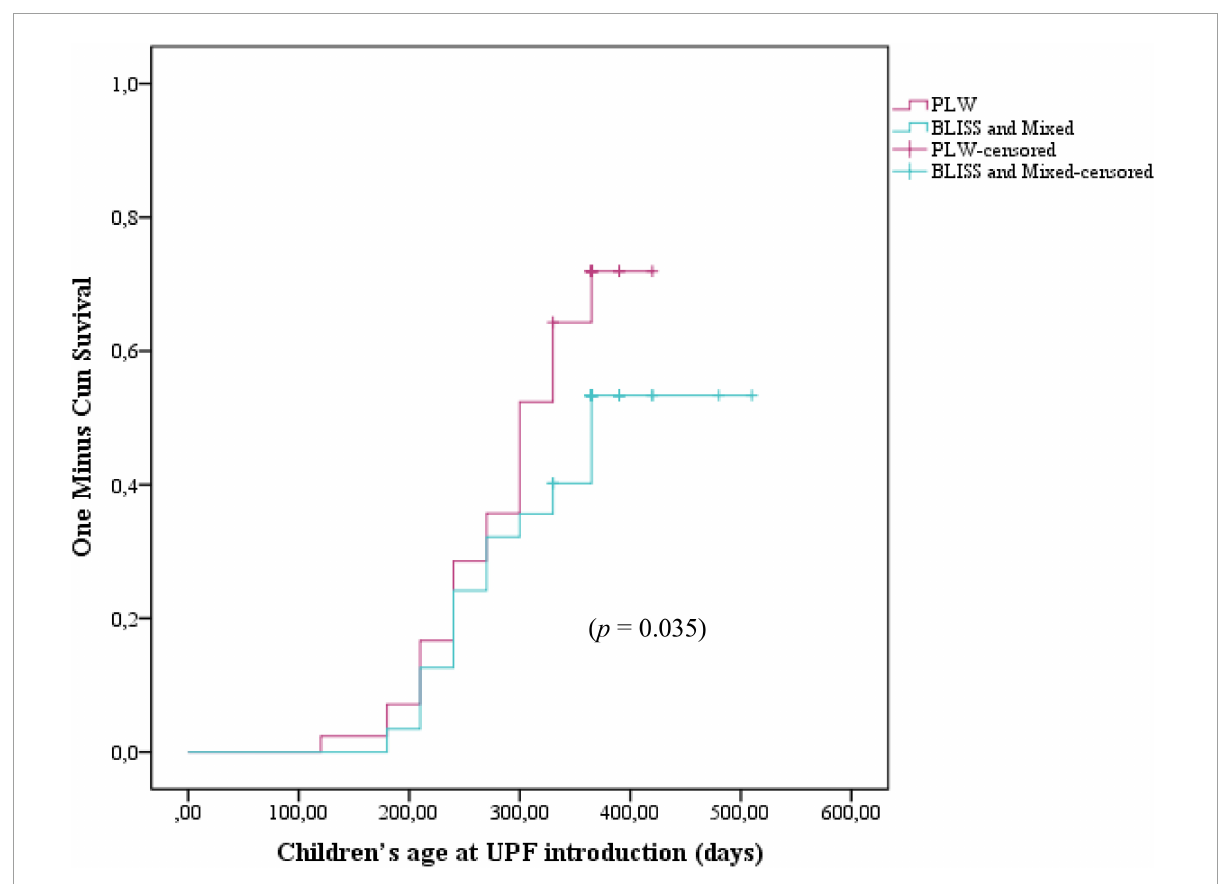
FIGURE4 Kaplan–Meier curve displaying the probability of being introduced to ultra-processed foods in the first year of children’s life according to interventions: PLW, BLISS, and mixed groups, Brazil, 2019–2021. PLW, parent-led weaning; BLISS, baby-led introduction to solids.